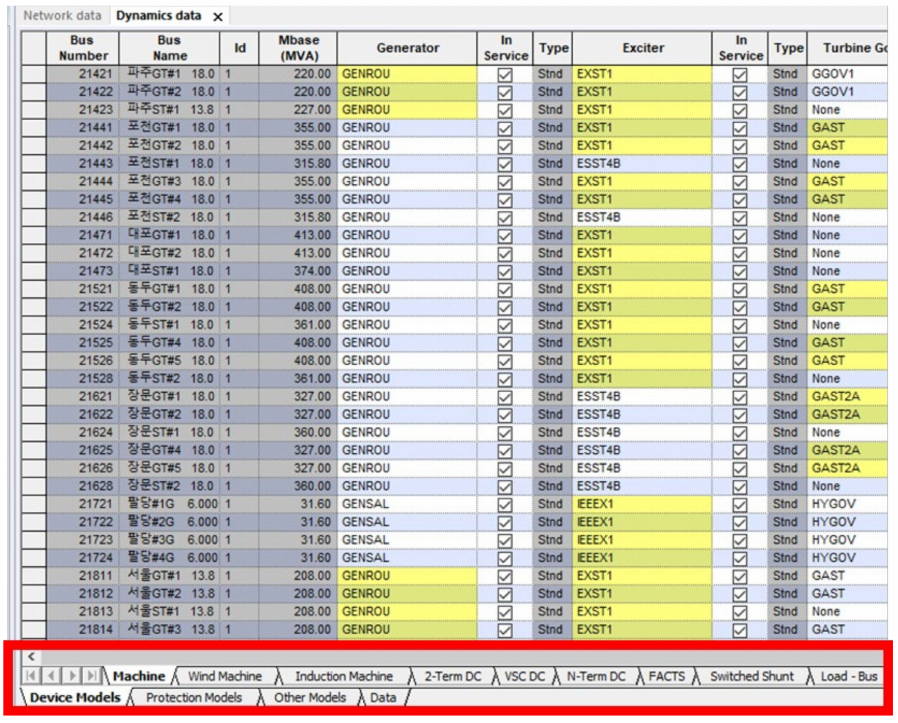
Figure A4. Dynamic DB based on PSS / E [26].